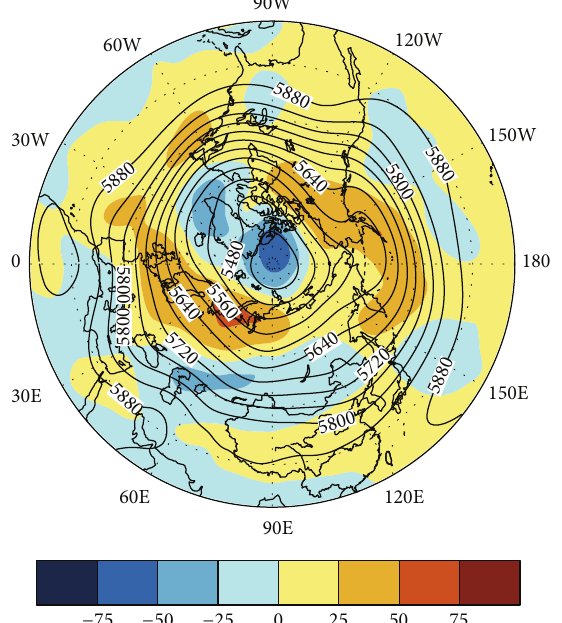
Figure 9: The distribution of climate mean geopotential height (solid line) and the anomaly (shaded area) in the summer 2013 at 500hPa in the northern hemisphere (gpm).